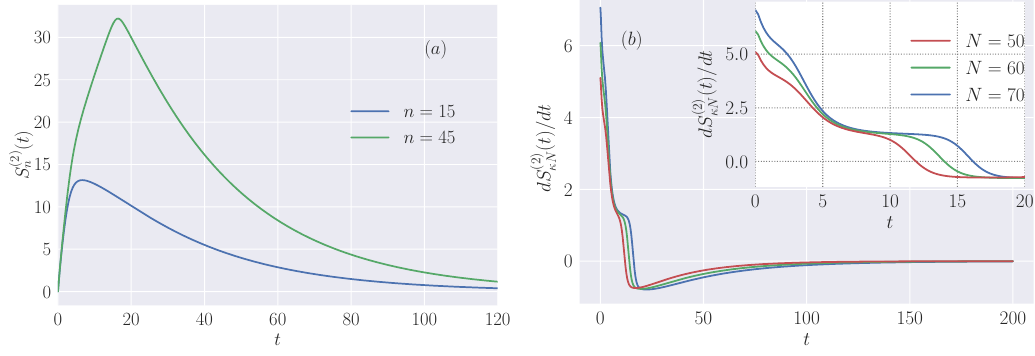
Figure 6 . Sub(cid:12)gure ( a ): R(cid:19)enyi entropy S (2) n ( t ) as a function of time for N = 60 and subsystems containing 15 and N 15 = 45 qubits. The plot corresponds to a random evolution in the presence (cid:0) of a global U(1) conserved charge, while the system is initialized as in eq. (3.36). The evolution parameters are set to (cid:21) 1 = 1 and (cid:21) 2 = 2. Sub(cid:12)gure ( b ): time derivative of the R(cid:19)enyi-2 entropy S (2) ( t ) as a function of time, for (cid:20) = 7 = 10 and increasing values of N . The evolution parameters (cid:20)N are set to (cid:21) 1 = 1 and (cid:21) 2 = 2. The inset shows the same plot in the time region close to t s (cf. the main